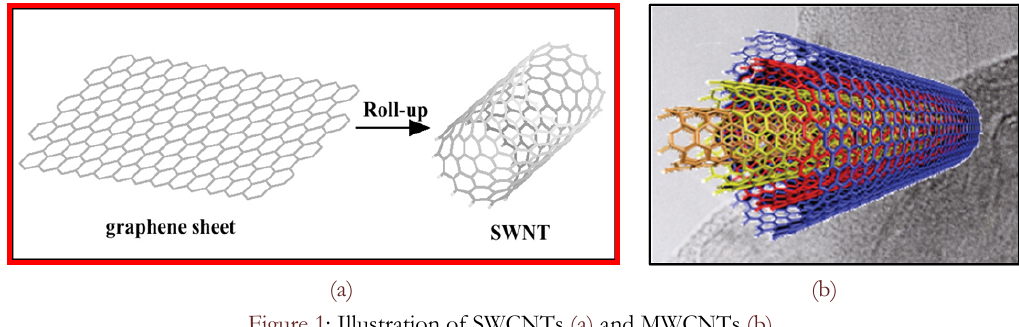
Figure 1: Illustration of SWCNTs (a) and MWCNTs